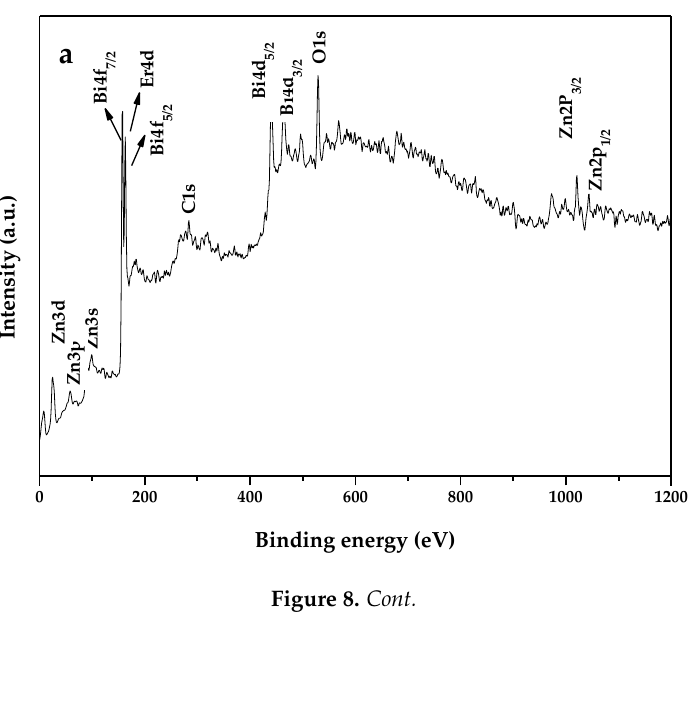
Table 2. Binding energies (BE) for key elements from ZnBiErO 4